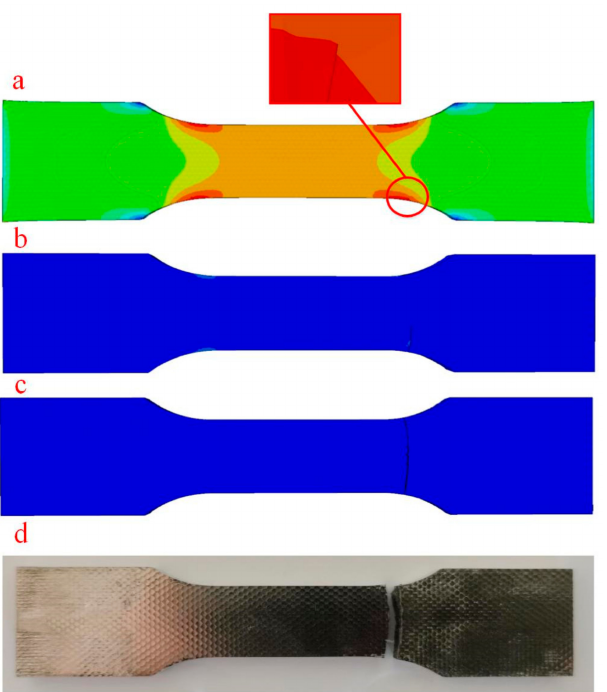
Figure 10. Comparison of fatigue crack growth process of fatigue specimen model with hexagonal bionic pit shape and test results: ( a ) initial crack initiation; ( b ) crack growth; ( c ) fatigue fracture; ( d ) fatigue fracture test